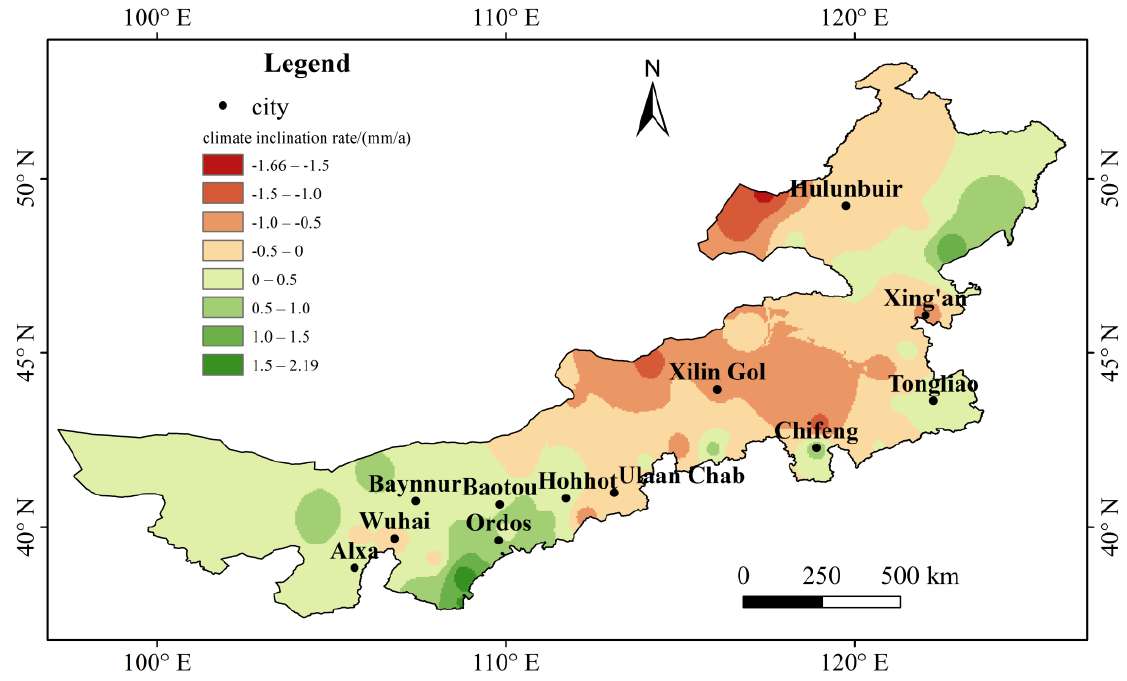
Figure 3. Precipitation inclination rate in Inner Mongolia during 1970 – 2017.